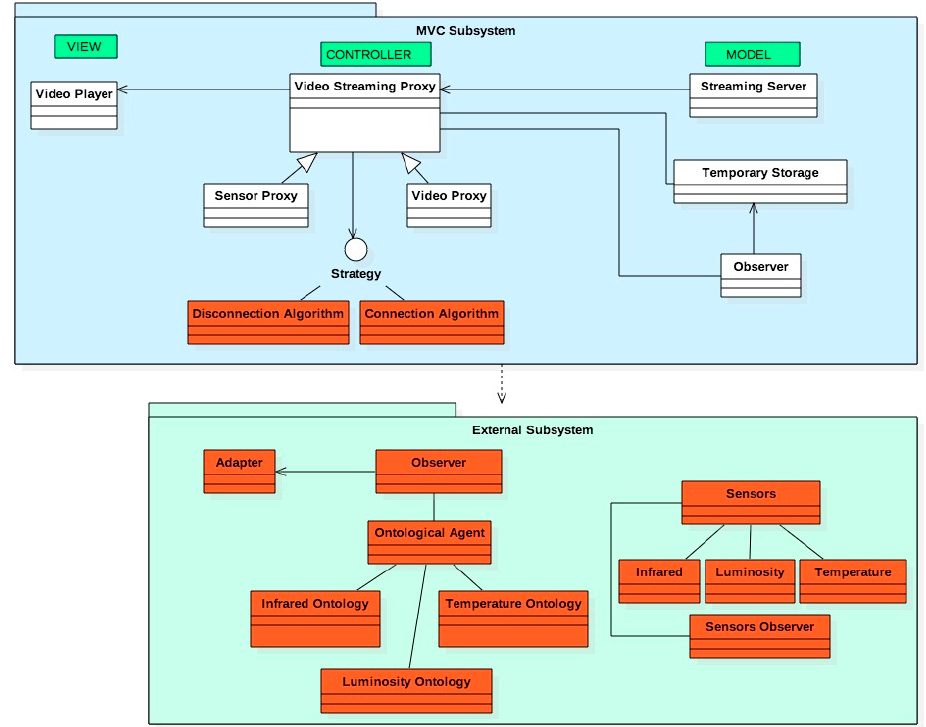
Figure 6. General software design pattern of the video surveillance system.